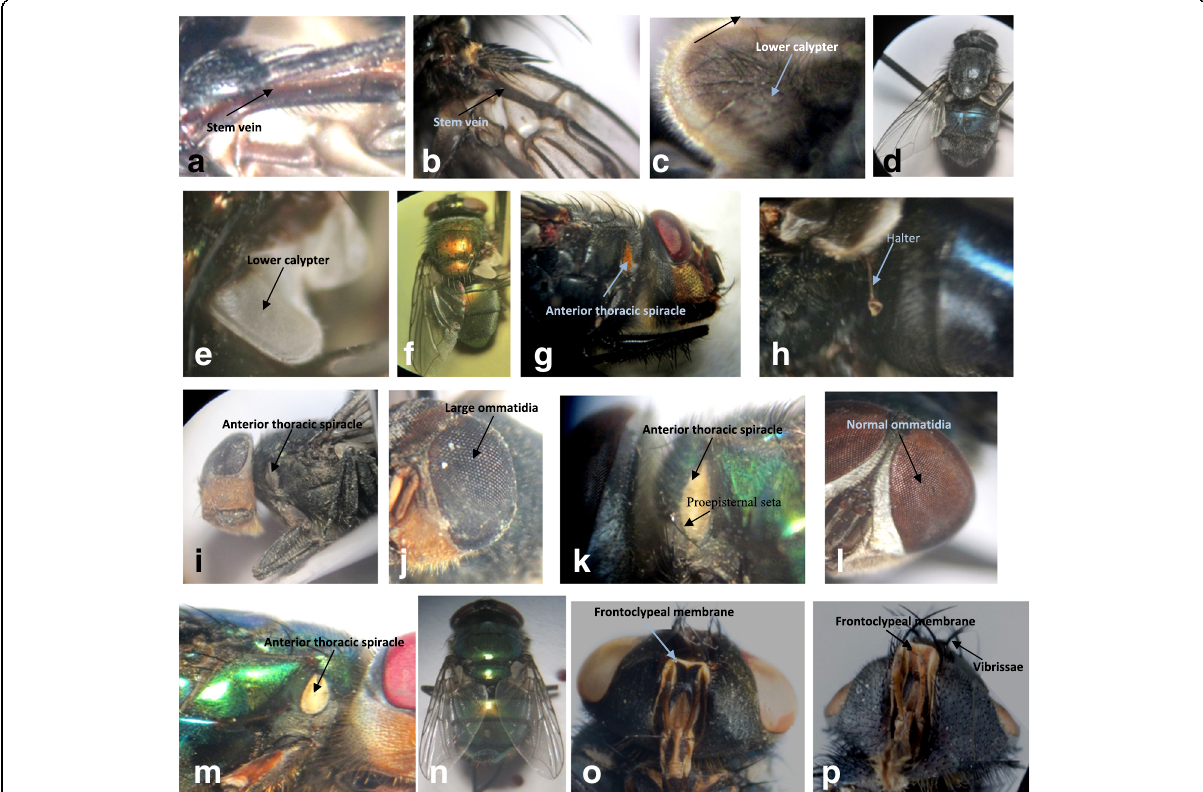
9- Wing with anal cell (cup) projected posteriorly as acute angular extension (Fig. 3l); thorax color largely metallic blue-green …………………………………… .... posteriorly; thorax color variable, not metallic 10- Frons always with 3 – 5 strong inclinate frontal bristles which are relatively similar to the two bristles, but if one or two present they located distant from and inclined oppositely to the two lateroclinate orbital bristles ……… .. ………… .. … ……… ...Piophilidae